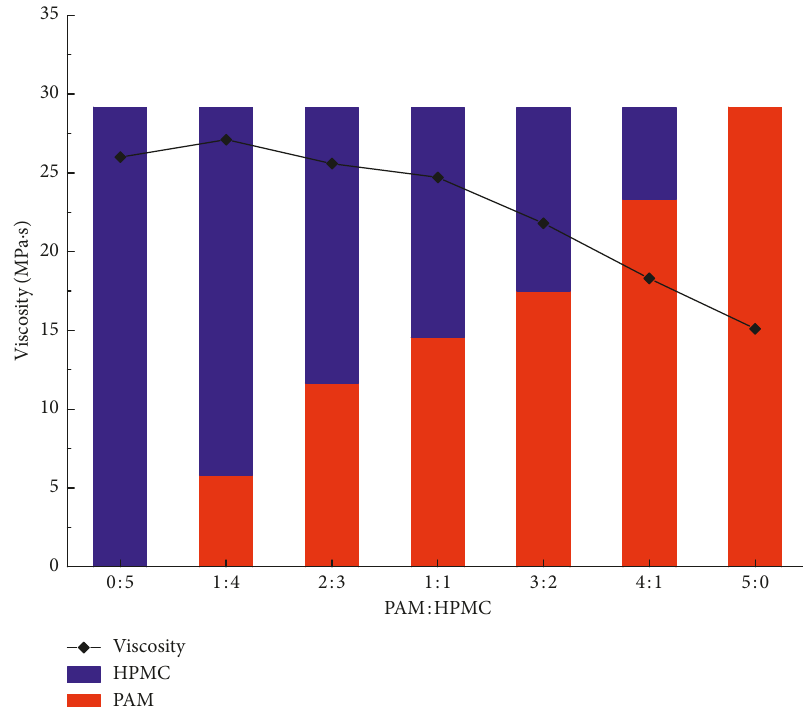
Figure 5: Impacts of the PAM: HPMC ratios on the adhesive